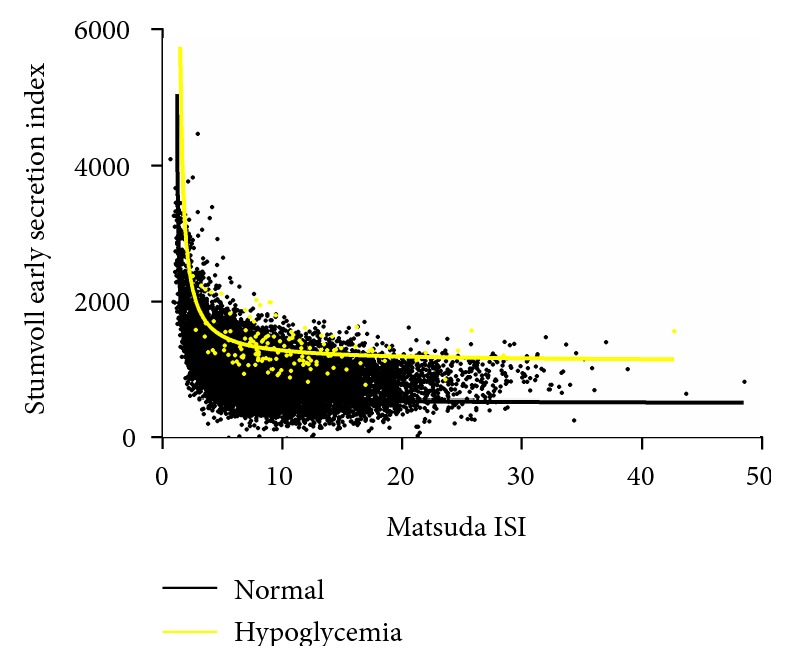
The insulin secretion of early stage and insulin sensitivity levels between participants with biochemical postprandial hypoglycemia and NGT.